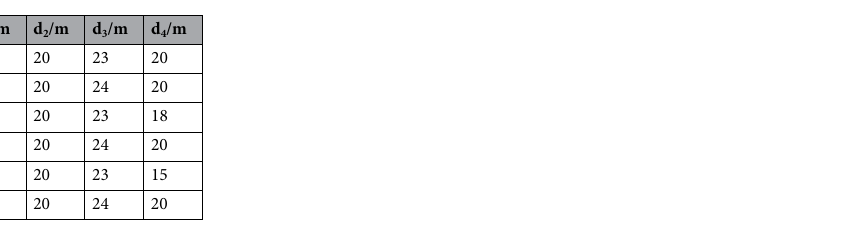
Table 4. Dynamic safety distance of multi-storey frame building with pile raft foundation on the top of